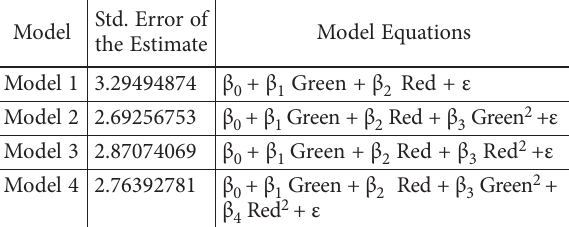
Table 7. The combinations of green and red channels Std. Error of Model the